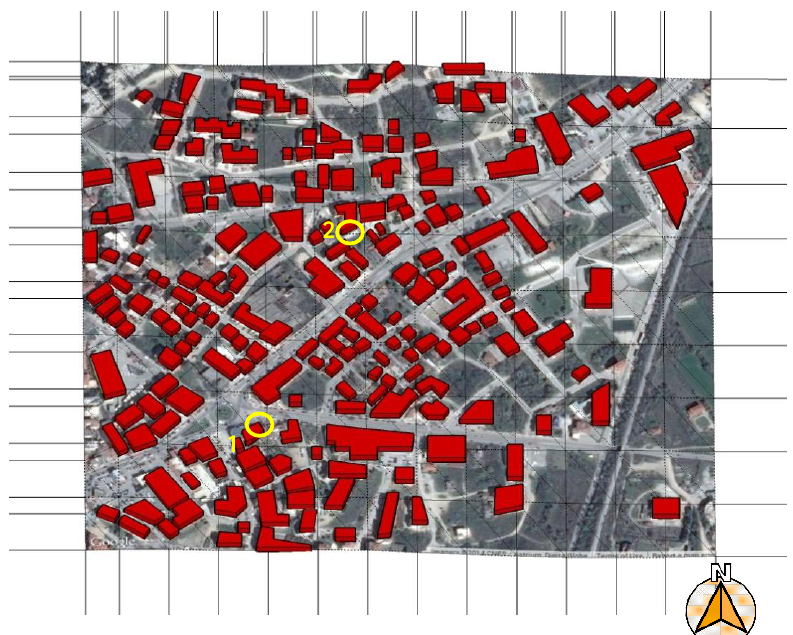
Figure 1. 3D representation of urban area being studied. Measurement positions are also indicated (1) for temperature measurements and (2) for wind measurements. (Satellite view of the city from Google Earth).